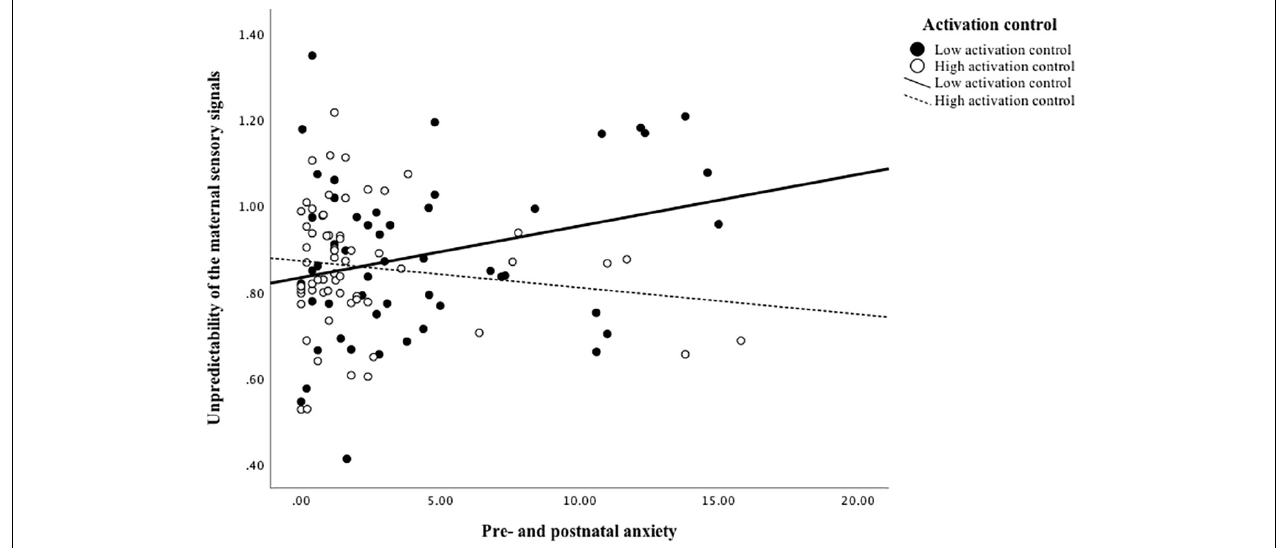
FIGURE 1 | Maternal anxiety predicting for the unpredictability of maternal sensory signals in low and high activation control groups (groups divided by median value 4.57 of activation